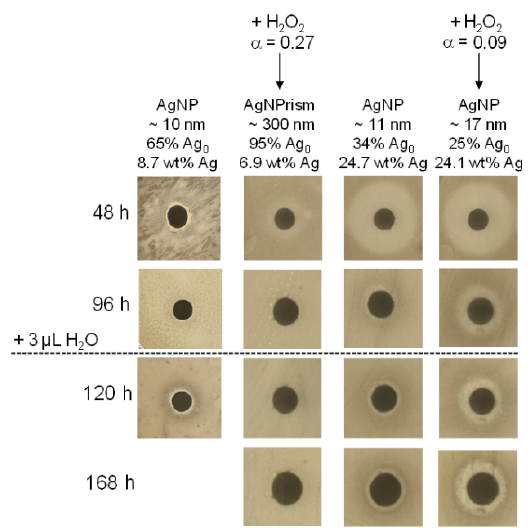
Figure 4. Evolution at various incubation times (48, 96, 120, 168 h) of inhibition halos of CNC/AgNP hybrids at two different initial AgNP contents (8.7 and 24.7 wt% Ag) with and without H 2 O 2 redox